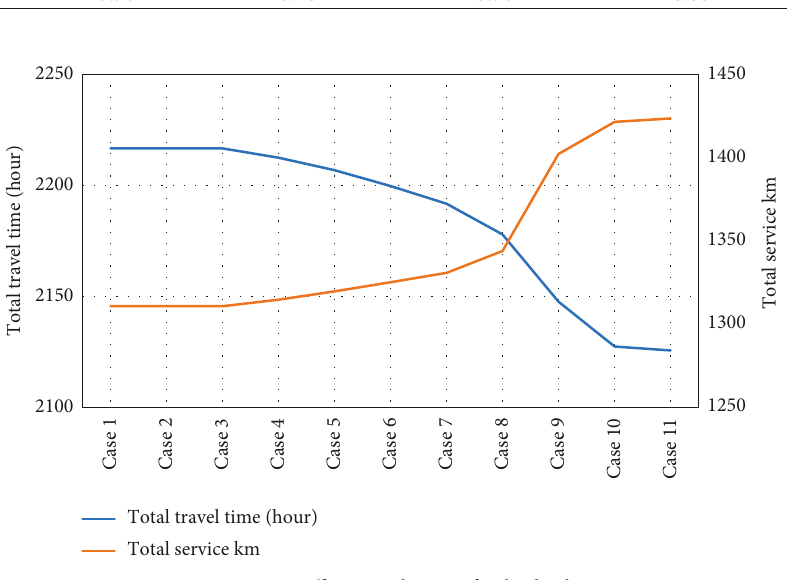
Figure 5: Pareto efficient solutions for both objectives. Table 3: Proposed headways and their corresponding maximum load and capacity